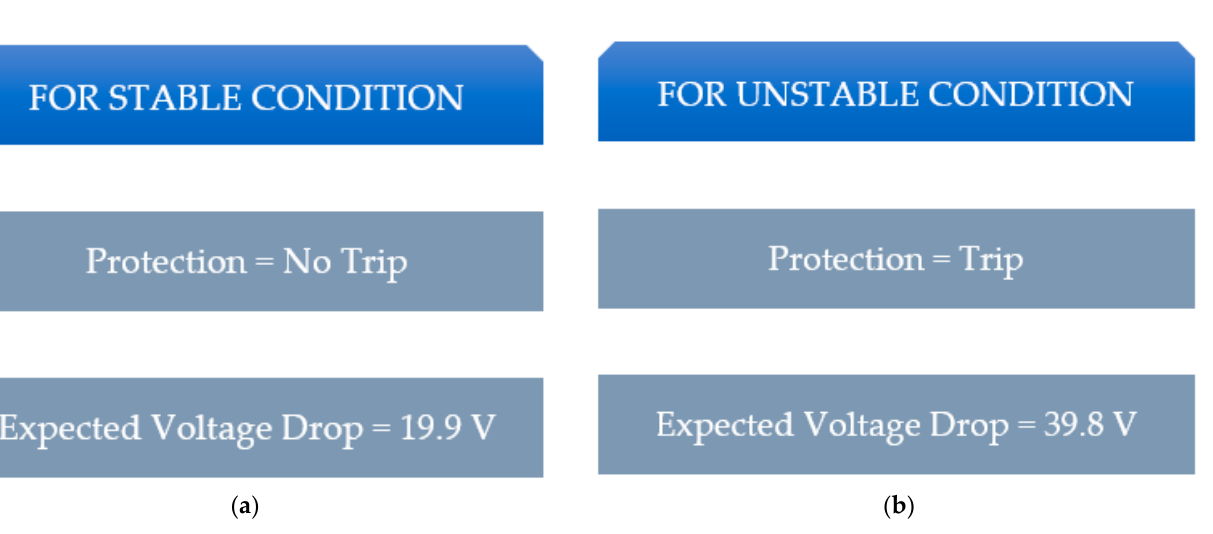
Figure 4. Expected results and relay operation for single-phase high-impedance differential protec- tion for the ( a ) stable condition and ( b ) unstable condition.